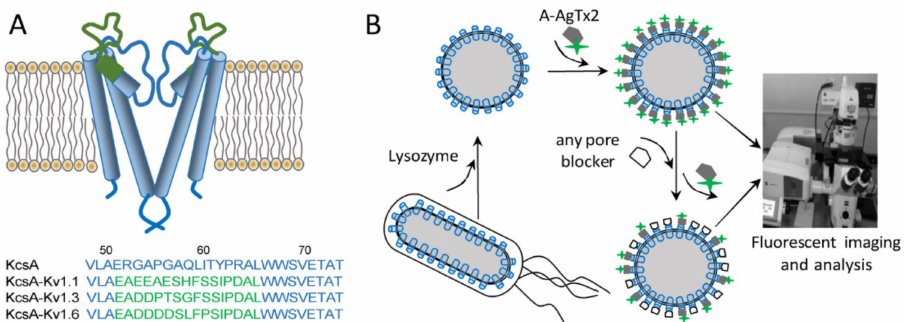
Figure 2. Hybrid KcsA–Kv1.x (x = 1, 3, 6) channels and their application in the analytical bioengi- neering system for the study of Kv1 channel blockers. ( A ) Structure of the hybrid KcsA–Kv1.x (x = 1, 3, 6) channels. Two of four channel subunits are shown for clarity. The green color in the structure and sequences indicates the blocker binding site of eukaryotic Kv1.x channels that was transferred to the KcsA channel. ( B ) A principle of the KcsA–Kv1.x (x = 1, 3, 6) channel application in the analytical bioengineering system. Hybrid channels expressed in the internal membrane of E. coli cells become accessible for interaction with the fluorescently labeled ligand A-AgTx2 after the lysozyme-mediated removal of the cell wall and the transformation of cells into spheroplasts. Binding of A-AgTx2 as well as the competitive binding of non-fluorescent pore blockers to KcsA–Kv1.x (x = 1, 3, 6) are detected and quantified using a laser scanning confocal